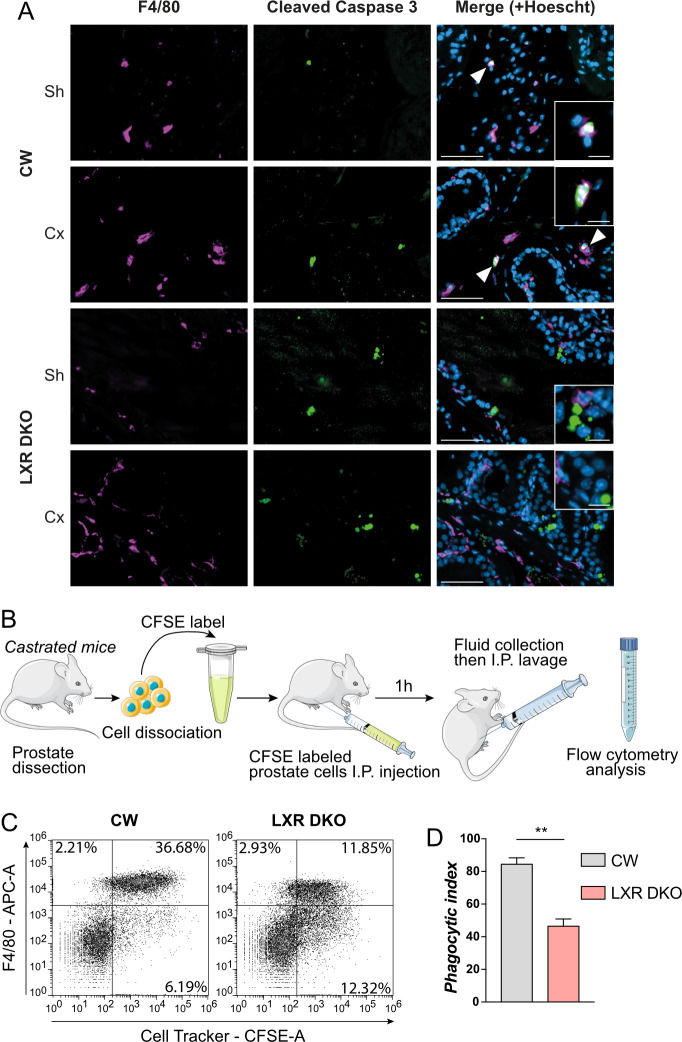
LXR-deficient mice present defective castration-induced apoptotic prostate cells clearance.(A) Immunohistological detection of macrophages marker F4/80+ and cleaved caspase 3-positive apoptotic cells in prostates of 1-week castrated mice or sham-operated mice indicates no colocalization of F4/80+ macrophages with cleaved caspase 3-positive apoptotic cells in LXR DKO mice in contrary to CW mice. (B) In vivo phagocytosis assay. CW or LXR DKO castrated for 4 days were culled, and whole prostates were dissected. Prostate cells were then dissociated and labeled with CFSE to allow tracking of cells from donor mice. Labeled cells were injected in the abdominal cavity of receiver mice and incubated for 1 hour. Abdomens of receiver mice were washed, and the collected fluid was analyzed by flow cytometry. (C and D) Flow cytometry analysis (C) of phagocytosed CFSE-labeled prostate cells by F4/80+ cells. Phagocytic index (D) shows a dramatic decrease of phagocytosis capacities of LXR DKO F4/80+ cells. Groups are composed of at least 4 animals. Bars represent mean ± SEM. Statistical analyses were performed via Mann–Whitney test. *p < 0.05, **p < 0.01, ***p < 0.001 and ns. Scale bars, 50 μm; insets, 10 μm. For numerical raw data, please see S1 Data. CFSE, carboxyfluorescein succinimidyl ester; CW, control wild-type; Cx, castrated; LXR, liver X receptor; LXR DKO, LXR alpha and beta double knock-out; ns, nonsignificant; Sh, sham-operated.